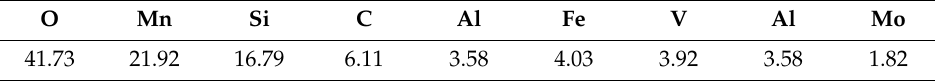
Figure 15. Microstructure of HM specimen. Table 4. Chemical compositions of inclusions in HM specimen (wt%).